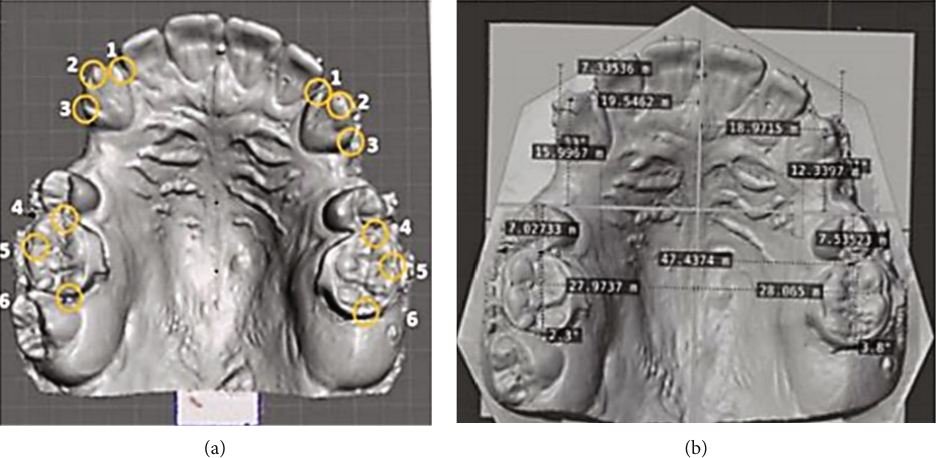
Figure 2: (a) Reference points: (1) most mesial point of the canines; (2) centre of cusp of canines; (3) most distal point of the canines; (4) most mesial point of the fi rst molars; (5) intermediate point between the mesiobuccal and distobuccal of the fi rst molar; (6) most distal point of the fi rst molar. (b) Linear and angular measurements taken from the cross-shaped